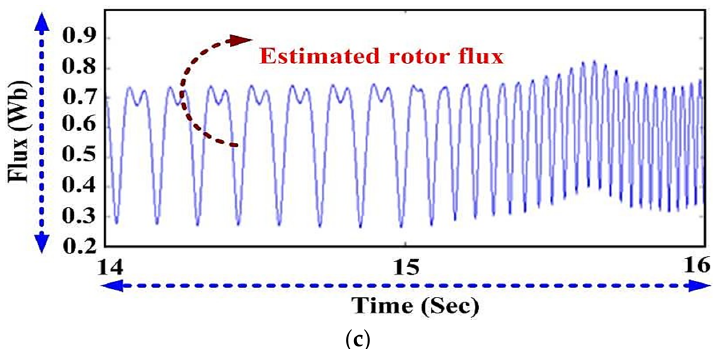
Figure 10. SMLO2: ( a ) estimated speed; ( b ) estimated torque and ( c ) estimated rotor flux.